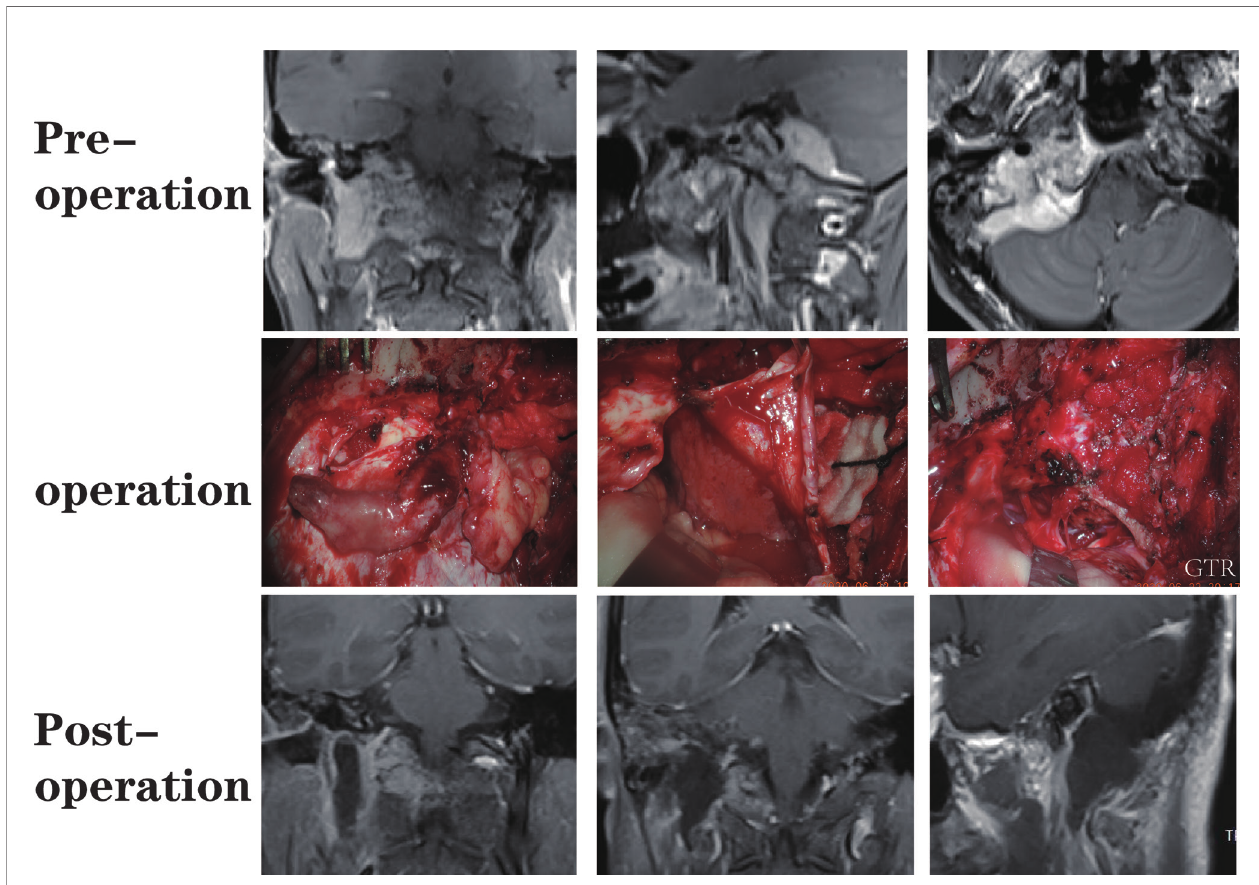
FIGURE 6 | A patient with a dumbbell-like jugular foramen meningioma who underwent suboccipital paracondylar-lateral cervical